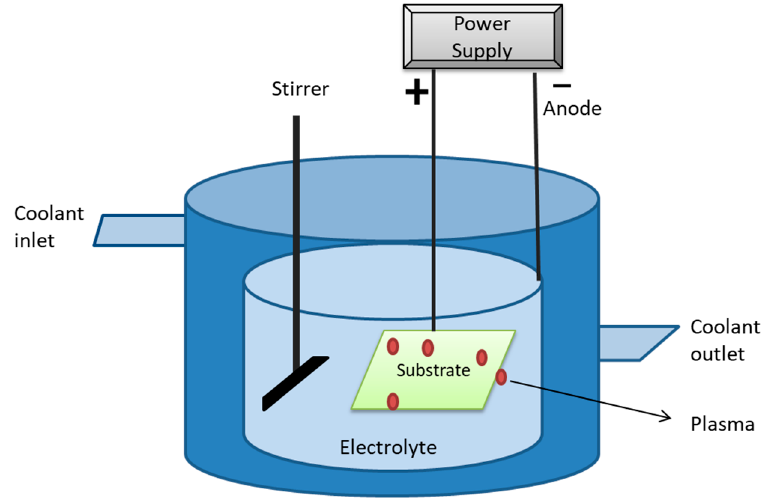
Figure 25. Schematic illustration of working principle of plasma immersion ion deposition technique. It includes a coolant inlet and outlet to maintain flow, stirrer to maintain uniformity, substrate dipped in electrolyte containing plasma, and power supply.